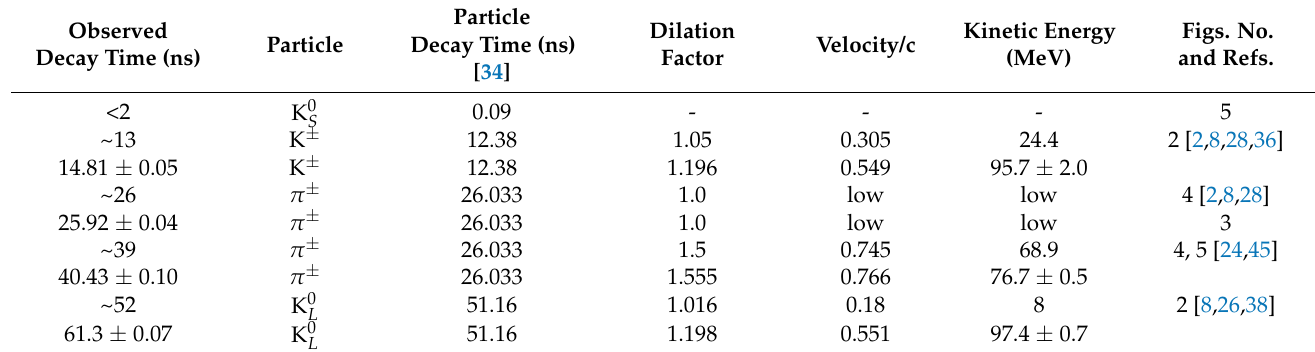
Table 1. Summary of meson decay time results. The decay time error limits given are standard errors from converged non-linear least-squares fits with two parameters (SigmaPlot 14, Systat Software Inc., Chicago, IL, USA).